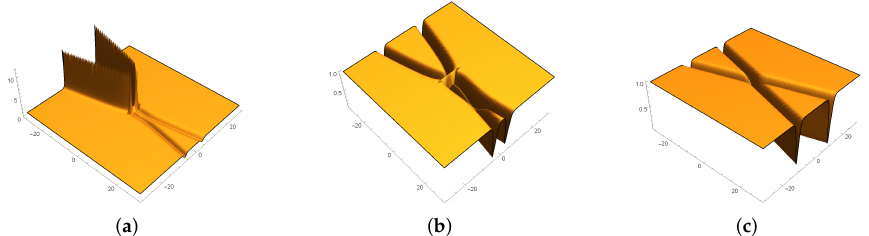
Figure 1. Elastic interactions via the solution (19a): ( a ) dark and antidark solitons with ρ = 1, λ 1 = − 0.1 i , c ( z ) = z and γ 1 = 0.4 − 0.5 i ; ( b ) two dark solitons with ρ = 1, λ 1 = − 0.1 i , c ( z ) = z 2 and γ 1 = 0.4 − 0.5 i ; ( c ) two dark solitons with ρ = 1, λ 1 = − 0.1 i , c ( z ) = e z and γ 1 = 0.4 − 0.5 i .